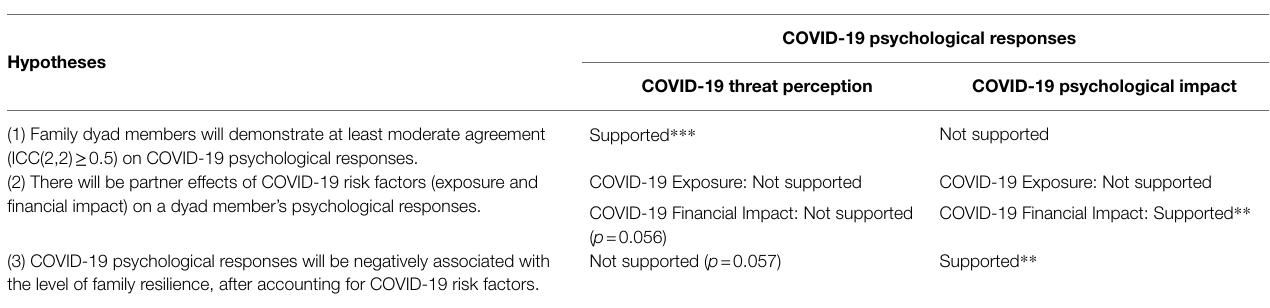
TABLE 5 | Overview of hypotheses and